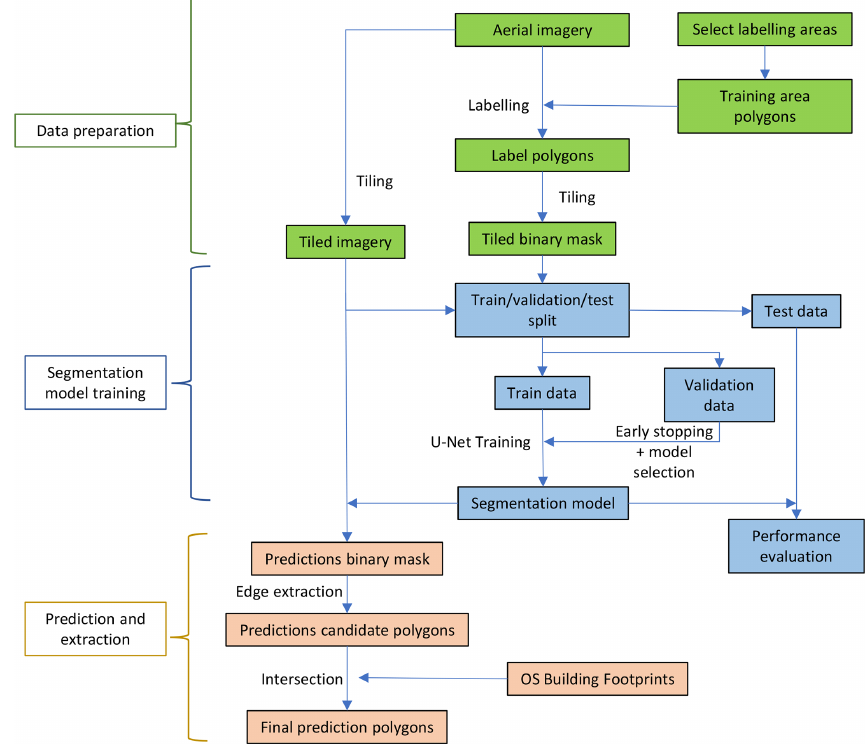
Figure 3. Workflow diagram of the overall segmentation pipeline.